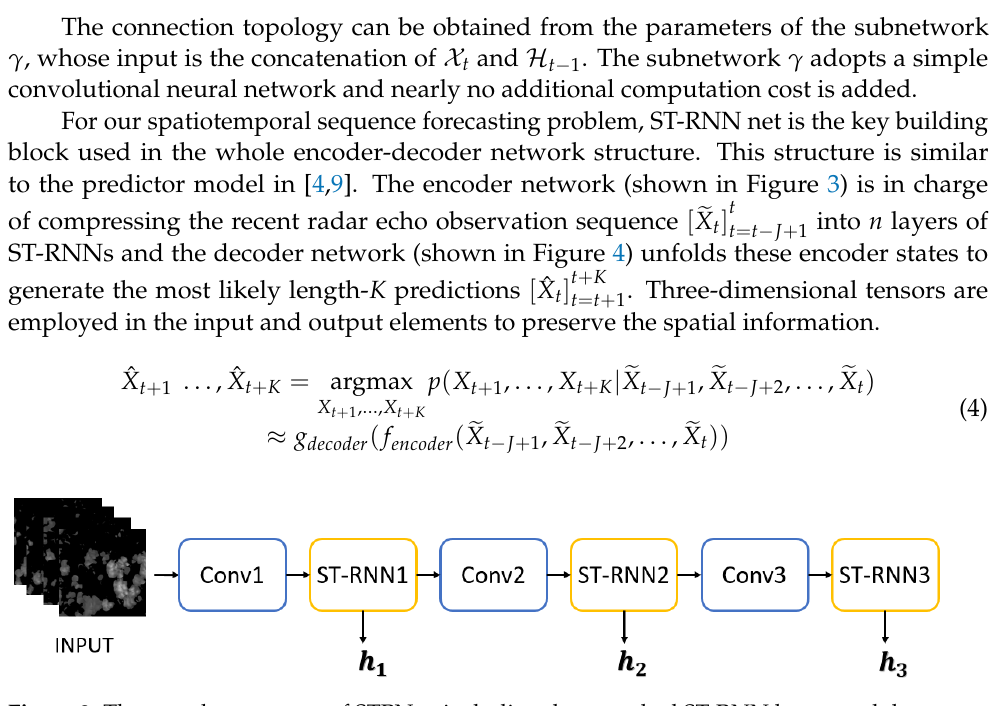
Figure 3. The encoder structure of STPNet, including three stacked ST-RNN layers and downsam- pling layers.